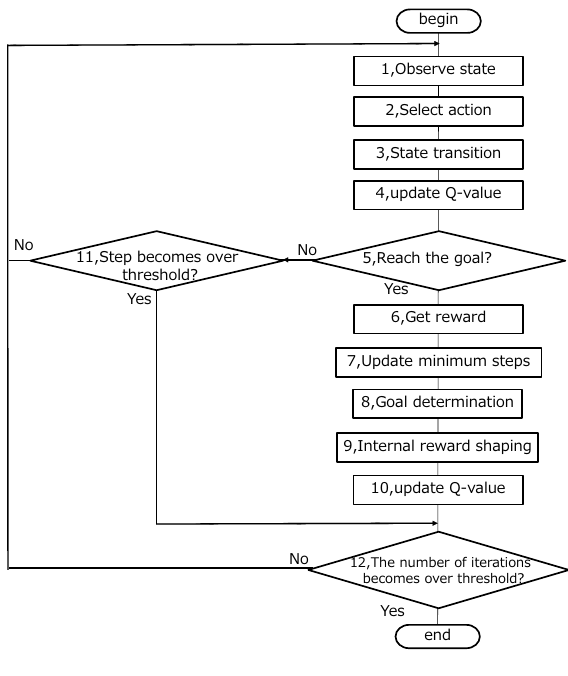
Figure 4: Flow chart of proposed